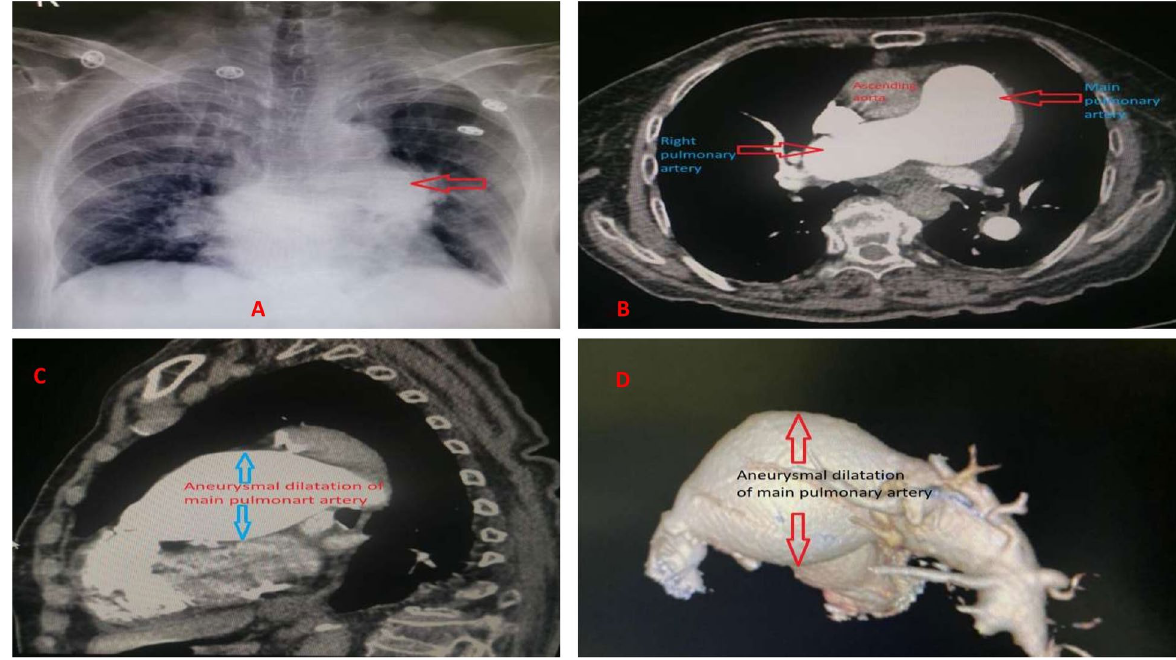
Fig. 1 A Chestradiograph PA view showing left perihilar opacity raising concerns (red arrow). B Axial view in chest CT showing dilated main pulmonary artery, right pulmonary artery, and ascending aorta. C Sagittal view in chest CT showing aneurysmal dilatation of main pulmonary artery. D Volume rendering technique CT showing aneurysmal dilatation of the main pulmonary